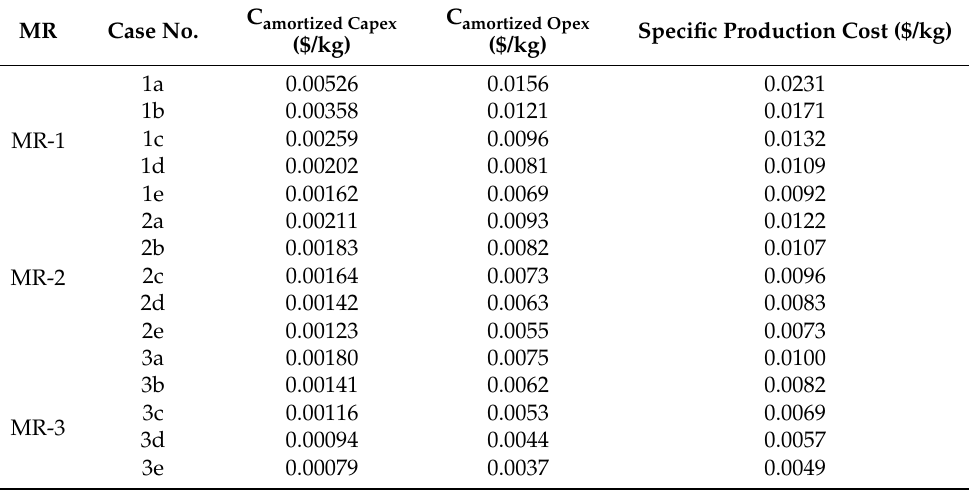
Table 10. Capital, operation and specific production cost of each case